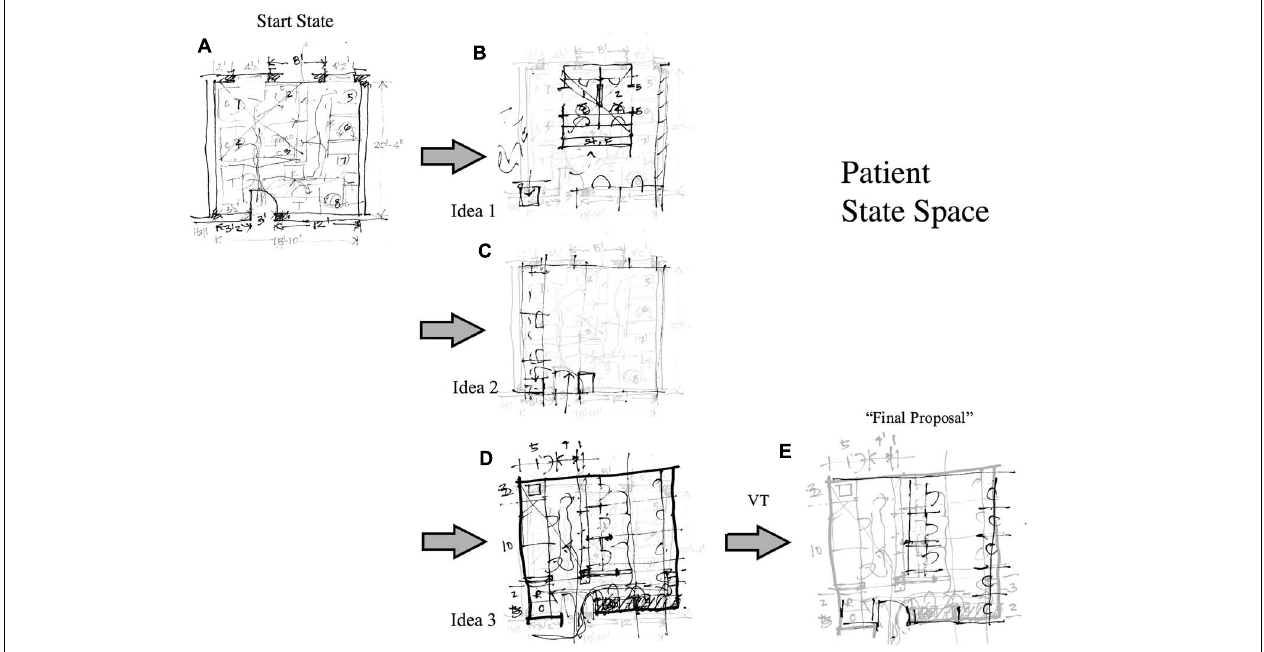
FIGURE 7 | Patient’s state space and transformation functions. LT = lateral transformation;VT = vertical transformation. Drawings B–E were executed on transparent tracing paper on top of drawing A . Reproduced from Goel and Grafman (2000).